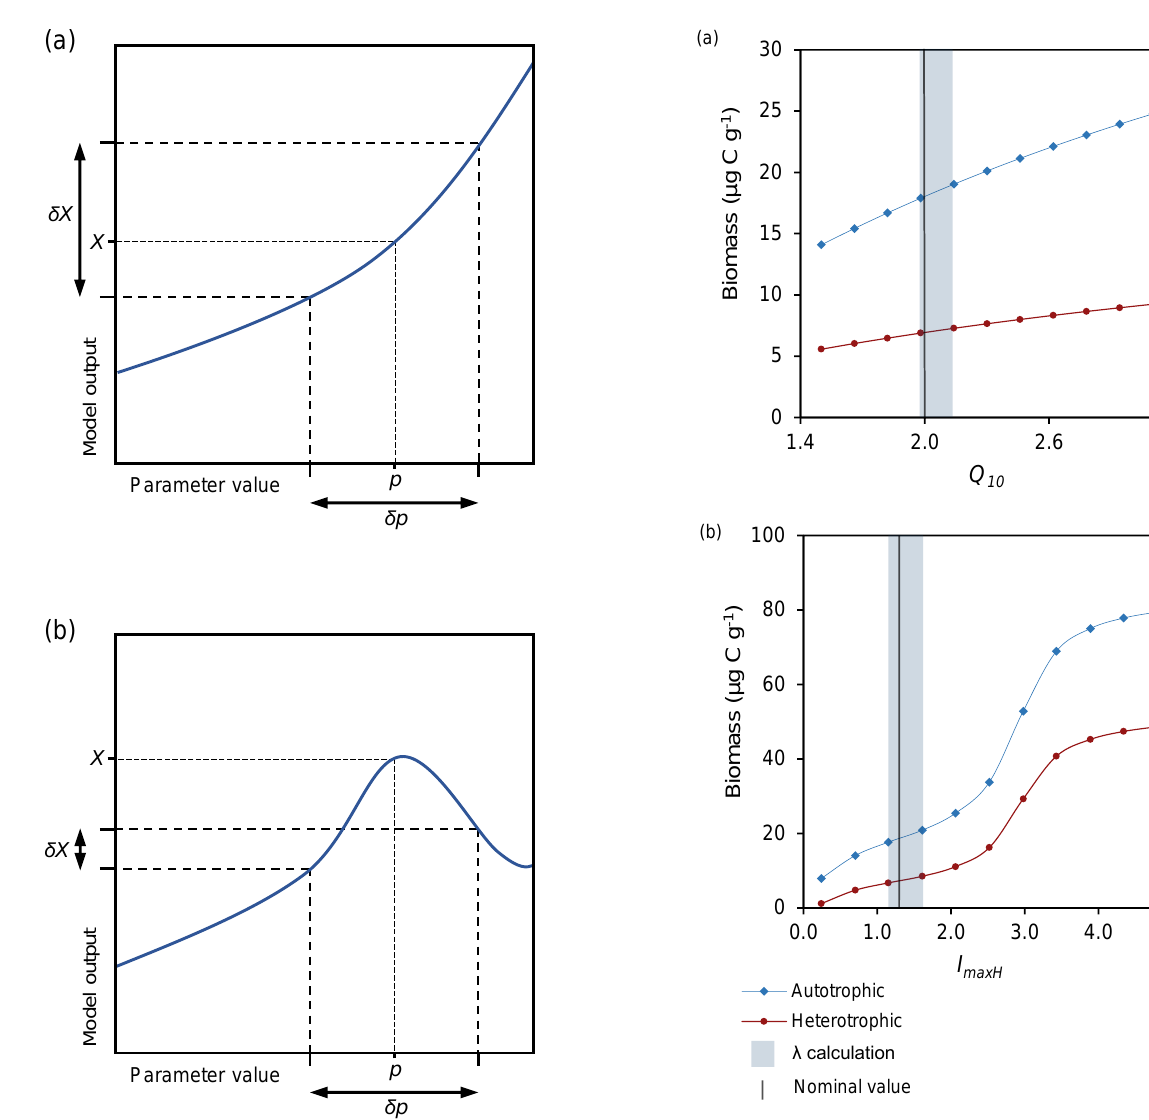
Figure 5. Illustration of calculation of sensitivity ( λ) where (a) the value of λ is representative of the sensitivity; (b) the value of λ is not representative of the sensitivity. In (b) the apparent sensitivity ( λ) will be low due to model behaviour either side of the nominal parameter value having an opposite sign, even though the model may be truly sensitive to that parameter.